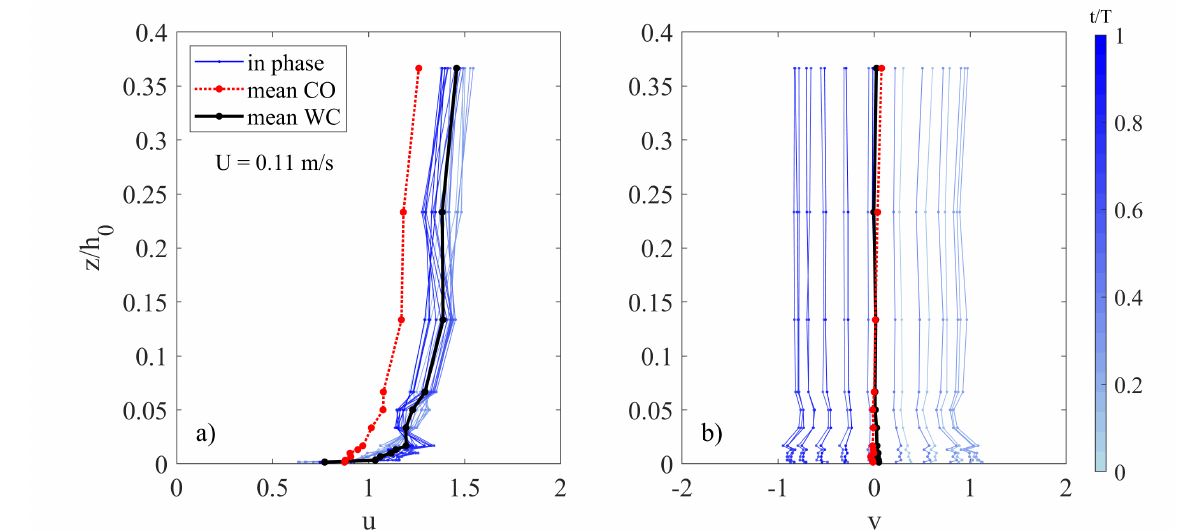
Figure 11. Phase-averaged velocities for tests 2 and 8 (CO and WC respectively) in the streamwise ( a ) and crosswise ( b ) directions. Time-averaged CO profile (red dashed line, red dot marker), time-averaged WC profile (black thick continuous line, black dot marker) and phase-averaged WC profile (see color bar). Mean velocity U = 0.11 m/s, local water depth h = 0.26 m.